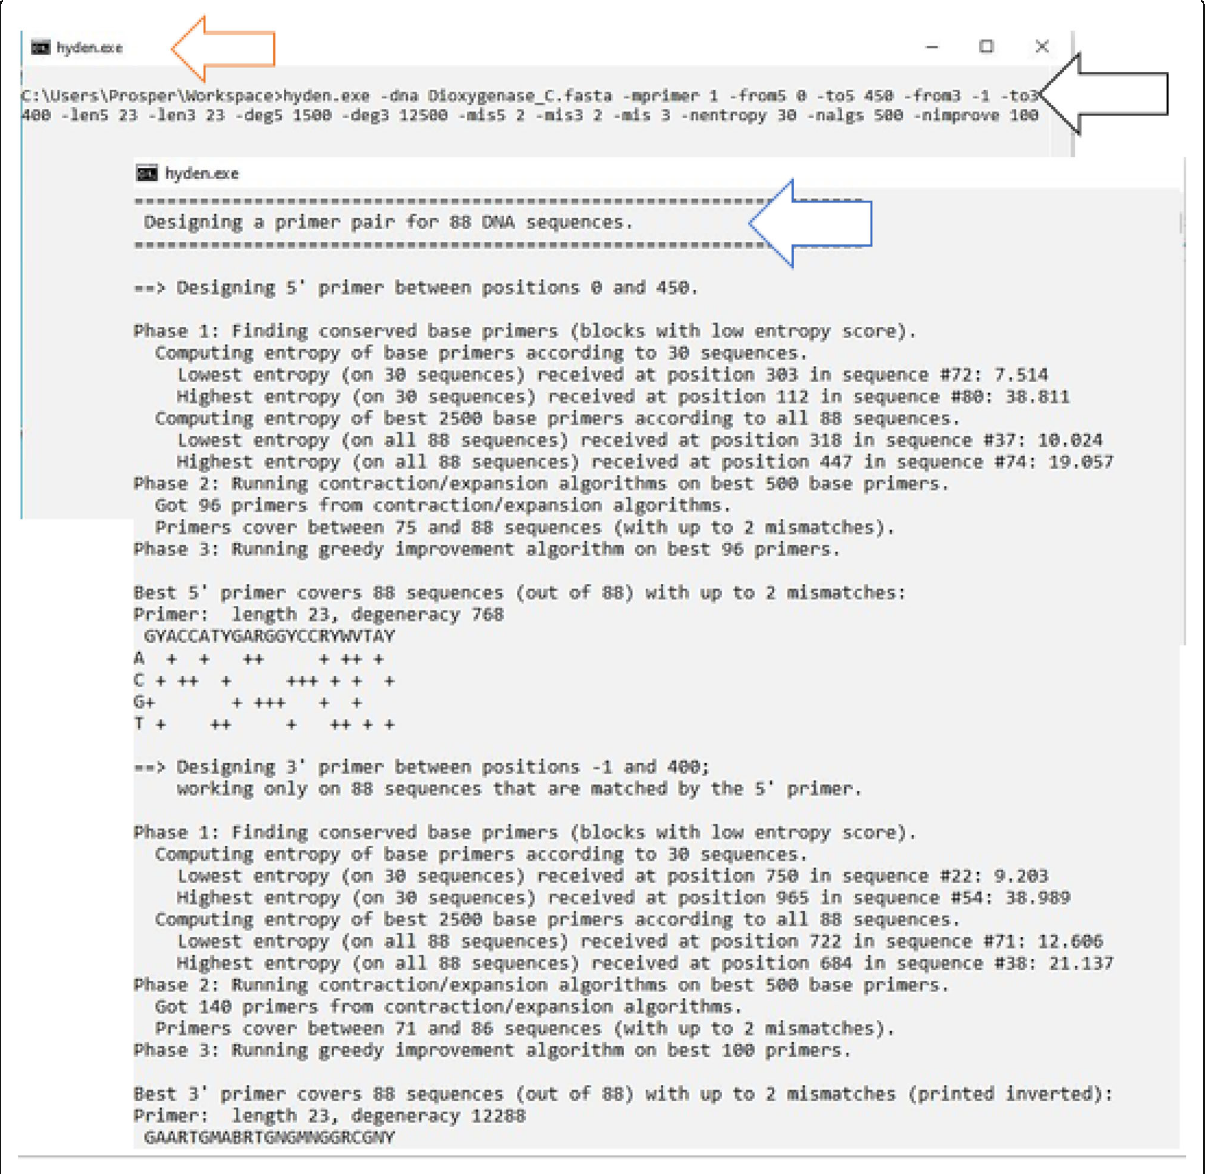
Fig. 8 Screenshot illustrating operation of hyden program for degenerate primer design. The orange arrow shows the hyden program interface. The black arrow shows the command-line parameters used in this study for designing the degenerate primer pair. The blue arrow depicts the running of the hyden program for